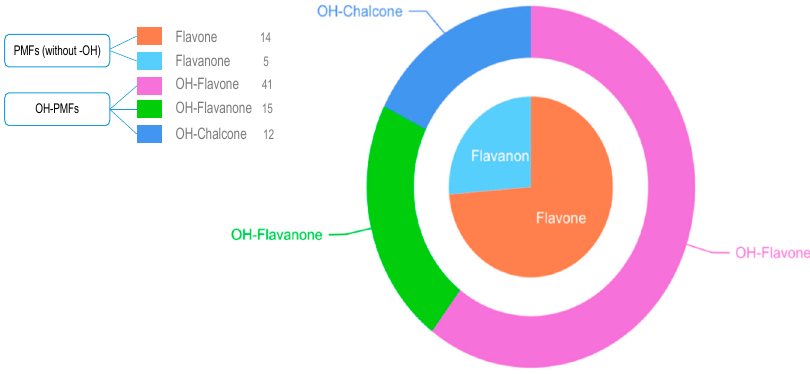
Figure 6. The classification of HTF metabolites.